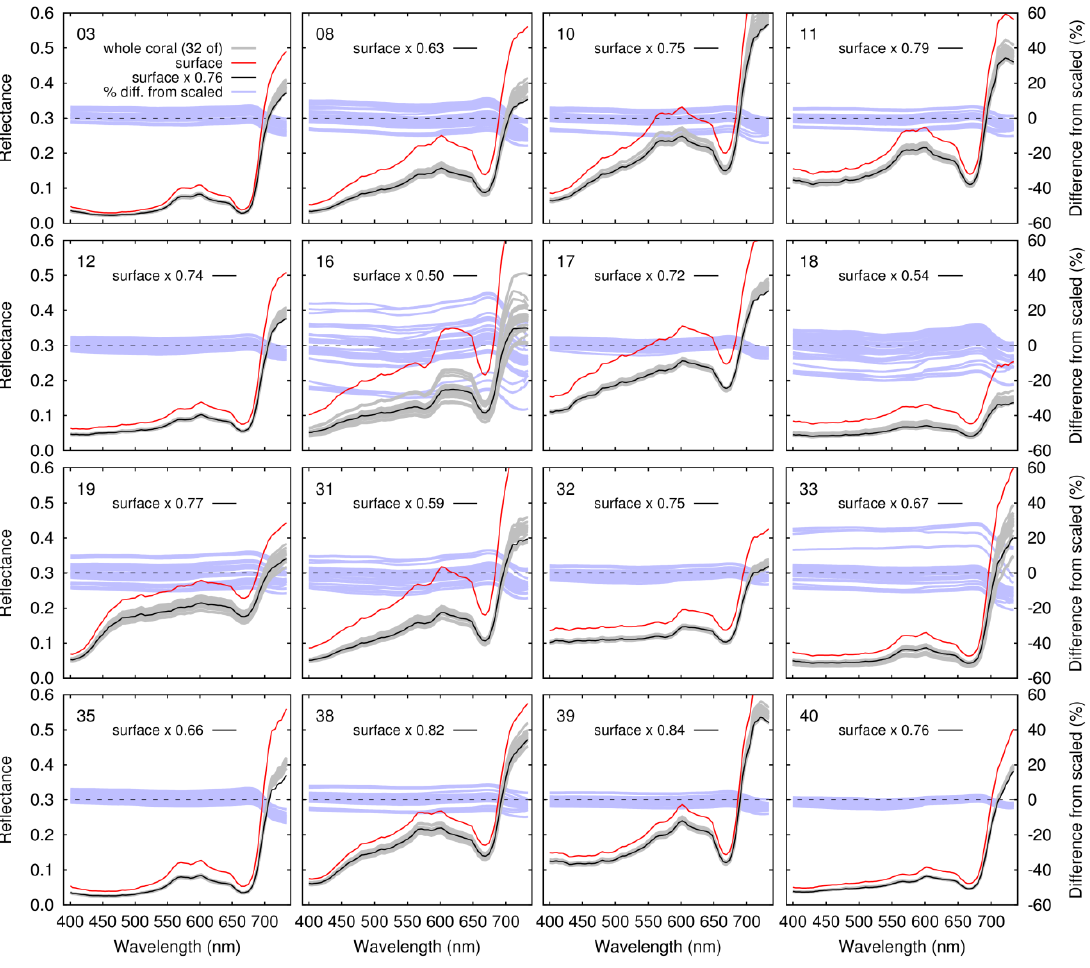
Figure 4. Reflectance over coral shape area only (no substrate) at the bottom of the water column with no interstitial water scattering or attenuation included. Plots show surface reflectance (red), reflectance over coral area under 32 treatments (grey), surface reflectance scaled by shading factor (black), and % difference of each treatment from scaled surface reflectance (light blue, right hand y- axis).